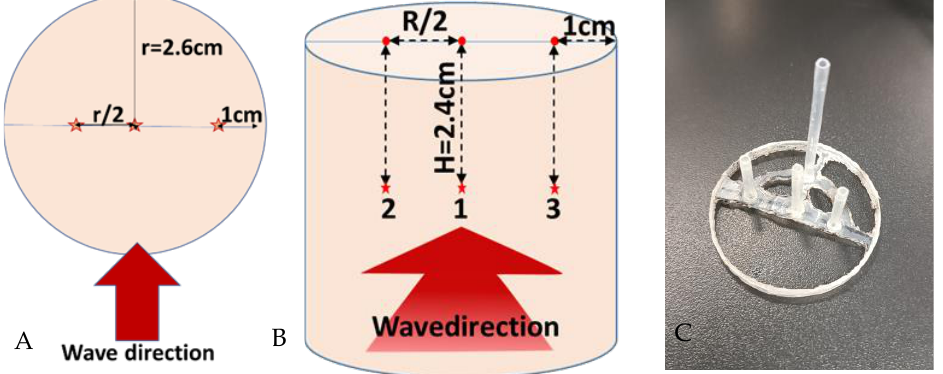
Figure 3. Position of optical fiber sensors in the sample ( A , B ) and sensor holder ( C ) (the red stars are the measured location, which is named 1, 2 and 3).